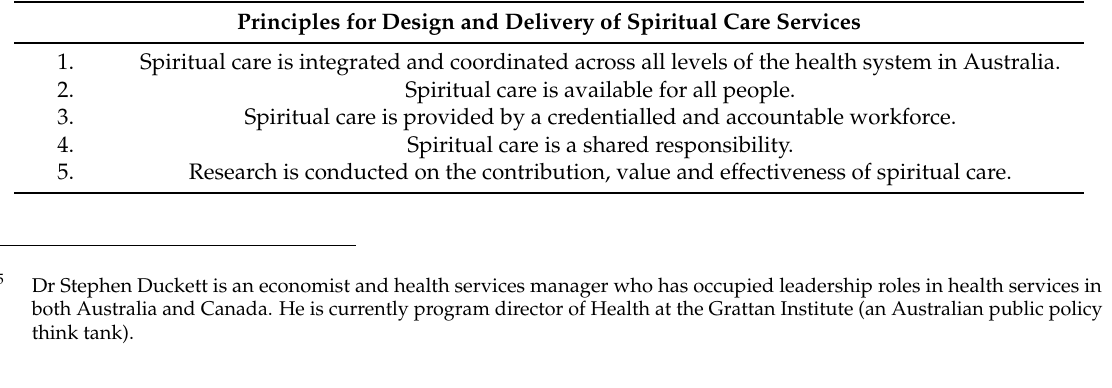
Table 1. Principles for design and delivery of spiritual care